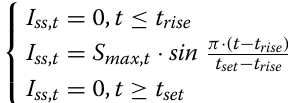
where I ss , t is the solar radiance (kW/m 2 ) of the simple sky model at time t , t rise and t set are the sunrise and sunset time, respectively. In the present work, as the panels are assumed to be roof-based, S max , t is the maximum terrestrial radiance in an hour I ETI , max , t multi- plied by the hourly clearness index CI t . I ETI , max , t is dependent on the zenith angle θ Z , t , eccentricity factor E 0 , and the peak value on terrestrial surface I 0 , shown below (Sung et al. 2015):